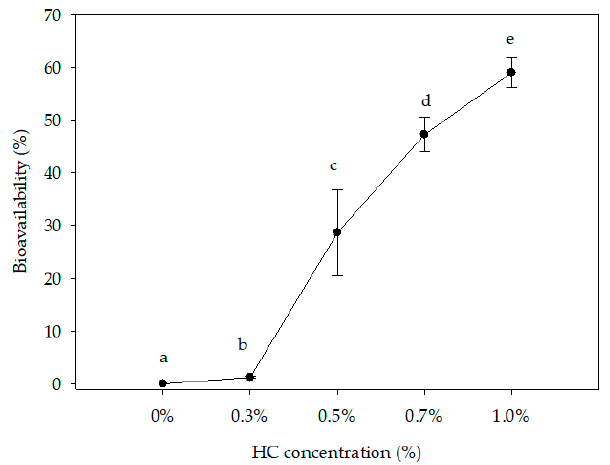
Figure 4. In vitro bioavailability of the hydrolyzed collagen (HC) present in the whey beverage. Values are means ± SD based on 3 observations. Means with different lowercase letters differ ( p ≤ 0.05).